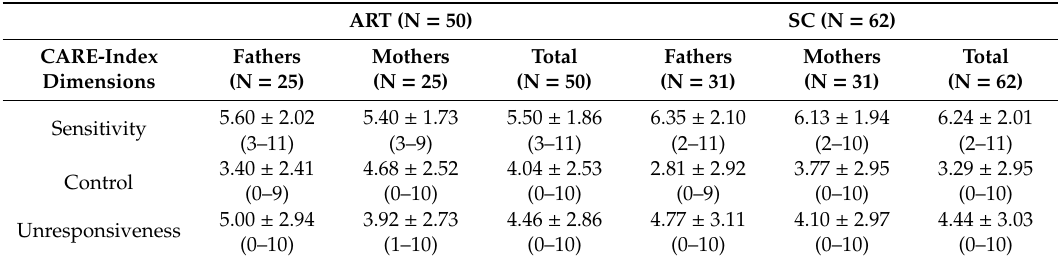
Table 3. Mean ± standard deviation (range) for interactive styles (CARE-Index dimensions) in ART and SC